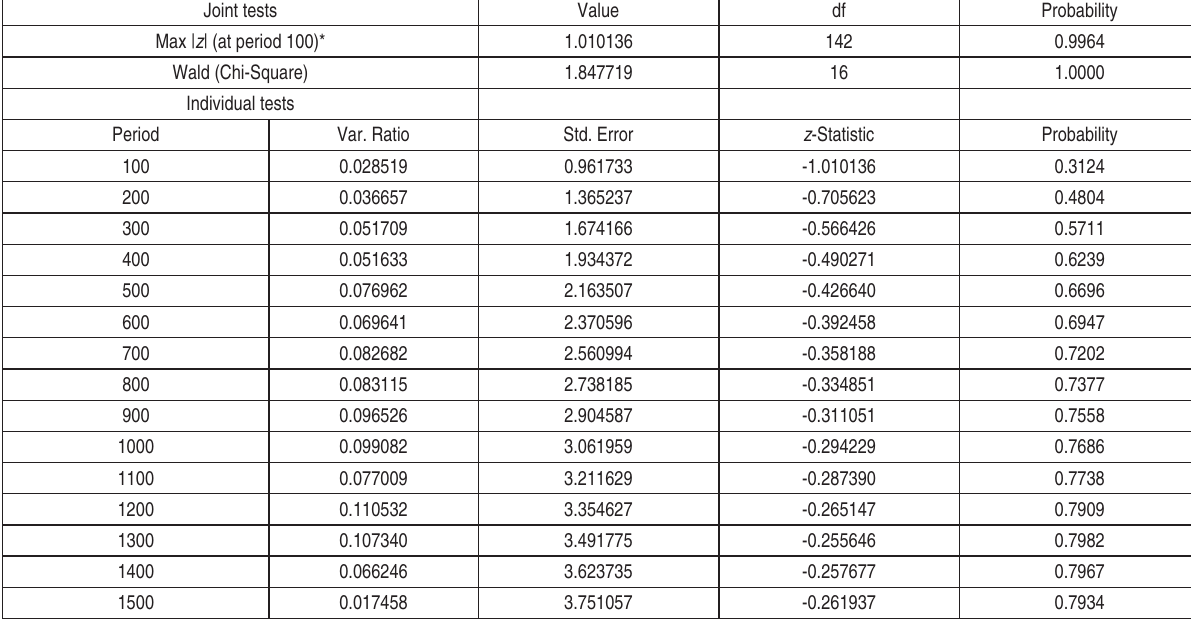
Table 7. Results of the variance ratio test DSE share index daily